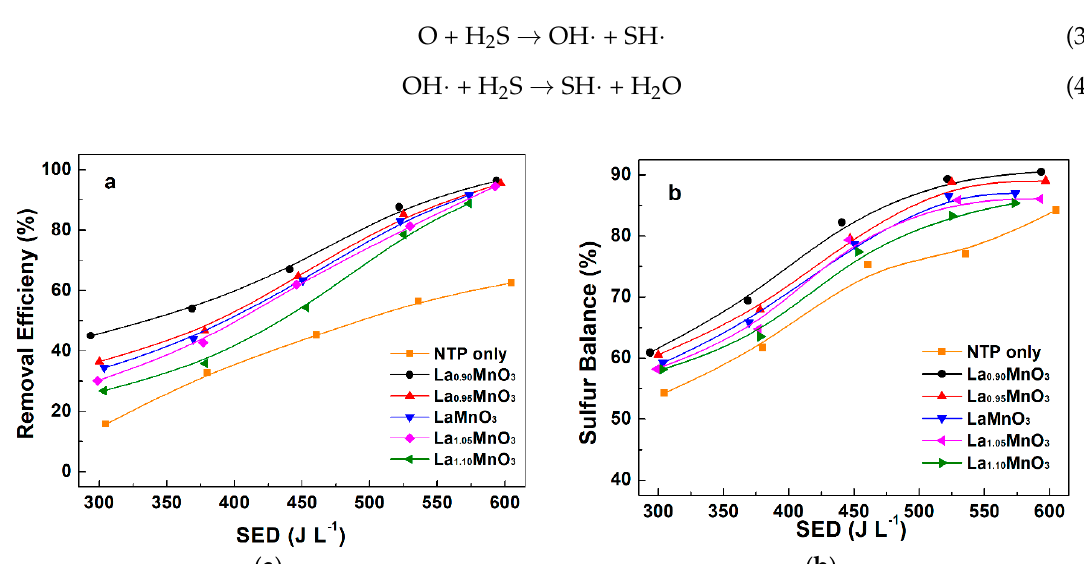
Figure 4. Effect of SED on plasma-catalytic removal of H 2 S over La x MnO 3 catalysts: ( a ) removal efficiency; and ( b ) sulfur balance of the plasma-catalytic process.